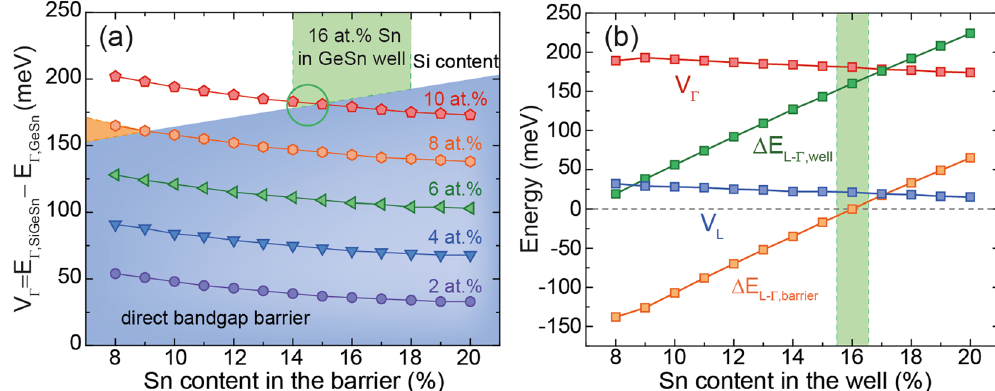
Figure 3. ( a ) Band discontinuities of the Γ -valley in a Ge 0.84 Sn 0.16 /SiGeSn MQW for different Sn contents in the barrier. ( b ) Directness of barrier and well, and band discontinuities for L- and Γ -valleys in dependence of the well Sn content in GeSn/SiGeSn MQWs achieving best band alignment for Γ .